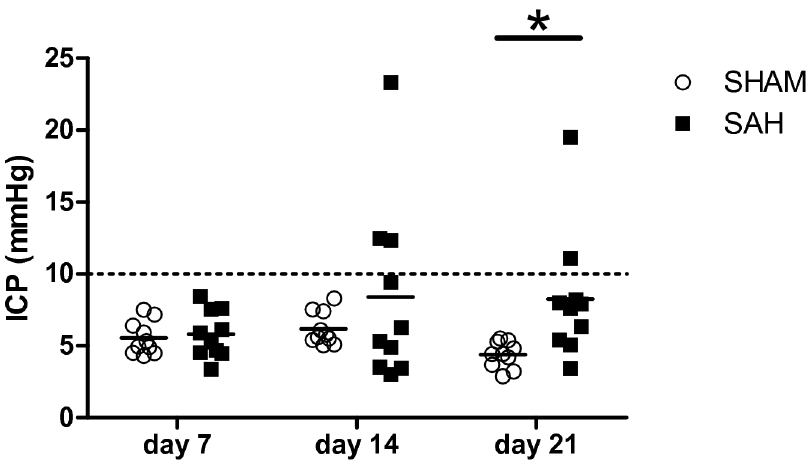
Figure 2. Time course of intracranial pressure. Intracranial pressure (ICP) in mmHg at three different time points in SHAM or SAH animals. Repeated-measures two-way ANOVA showed a significantly different time course of ICP in SHAM or SAH animals (p<0.05). * p<0.05 for the post-hoc comparison of SHAM vs. SAH at day 21 (Bonferroni-corrected).